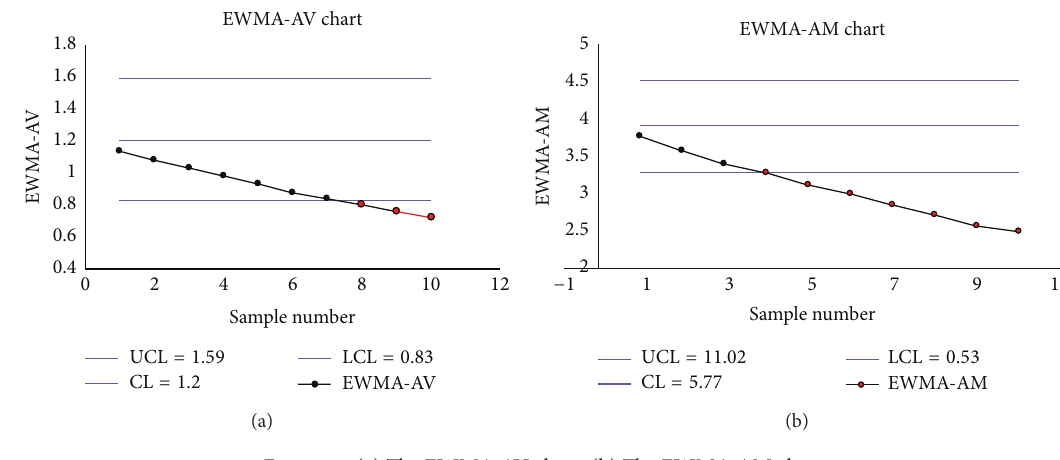
Figure 5: (a) The EWMA-AV chart. (b) The EWMA-AM chart.